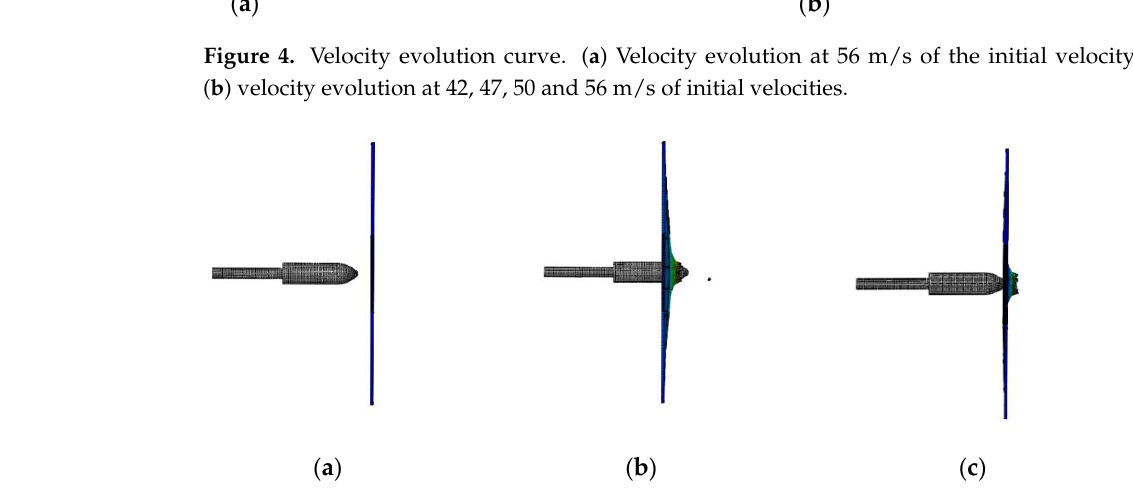
Figure 4. Velocity evolution curve. ( a ) Velocity evolution at 56 m/s of the initial velocity, and ( b ) velocity evolution at 42, 47, 50 and 56 m/s of initial velocities.